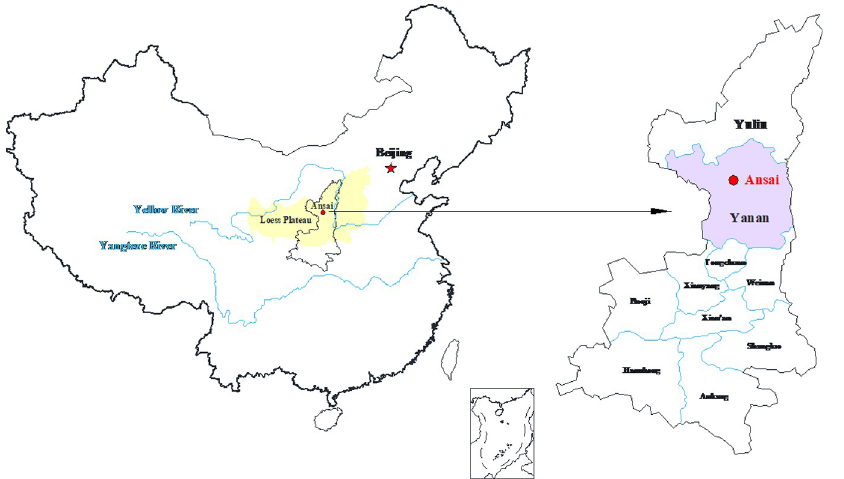
Fig 1. Distribution of loess in